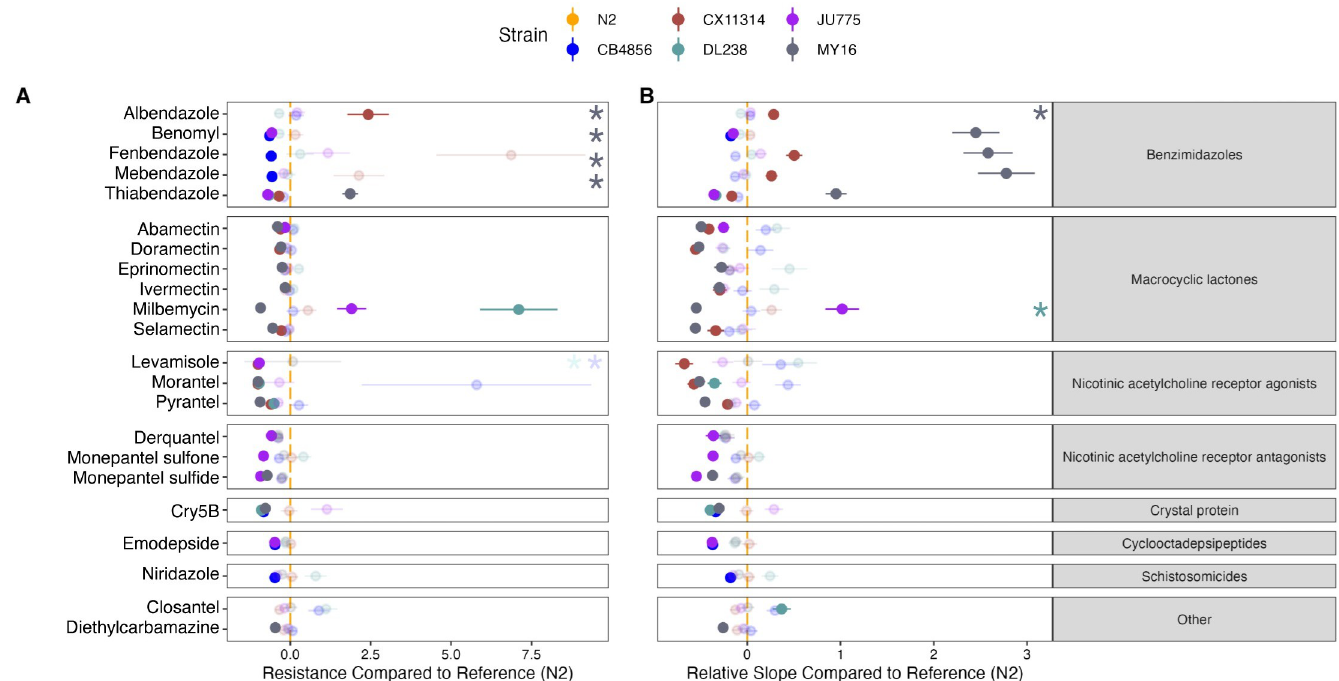
Fig 8. Variation in EC 10 and dose-response slope estimates can be explained by genetic variation across strains. (A) The relative potency of each anthelmintic for each strain compared to the N2 strain is shown. Solid points denote strains with significantly different relative resistance to that anthelmintic compared to the N2 strain (Student’s t-test and subsequent Bonferroni correction with a p < 0.05). Faded points denote strains not significantly different than the N2 strain. Asterisks denote adj strains with normalized estimates greater than ten compared to the N2 strain. See S14 Fig for the relative potency of all strains in each anthelmintic. Anthelmintic drugs with undefined EC 10 estimates (estimates greater than the maximum dose to which animals were exposed) are not shown. (B) For each anthelmintic, the relative steepness of the dose-response slope inferred for that strain compared to the N2 strain is shown. Solid points denote strains with significantly different dose-response slopes for that anthelmintic compared to the N2 strain (Student’s t-test and subsequent Bonferroni correction with a p adj < 0.05). Faded points denote strains without significantly different slopes than the N2 strain. Asterisks represent strains with slope estimates greater than 20 compared to the N2 strain. See S15 Fig for the slope estimates of all strains in each anthelmintic. Anthelmintic drugs with undefined slope estimates are not shown. The broad class to which each anthelmintic belongs is denoted by the strip label for each facet.